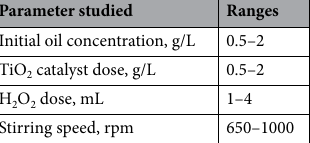
Table 1. Experimental parameters studied and their